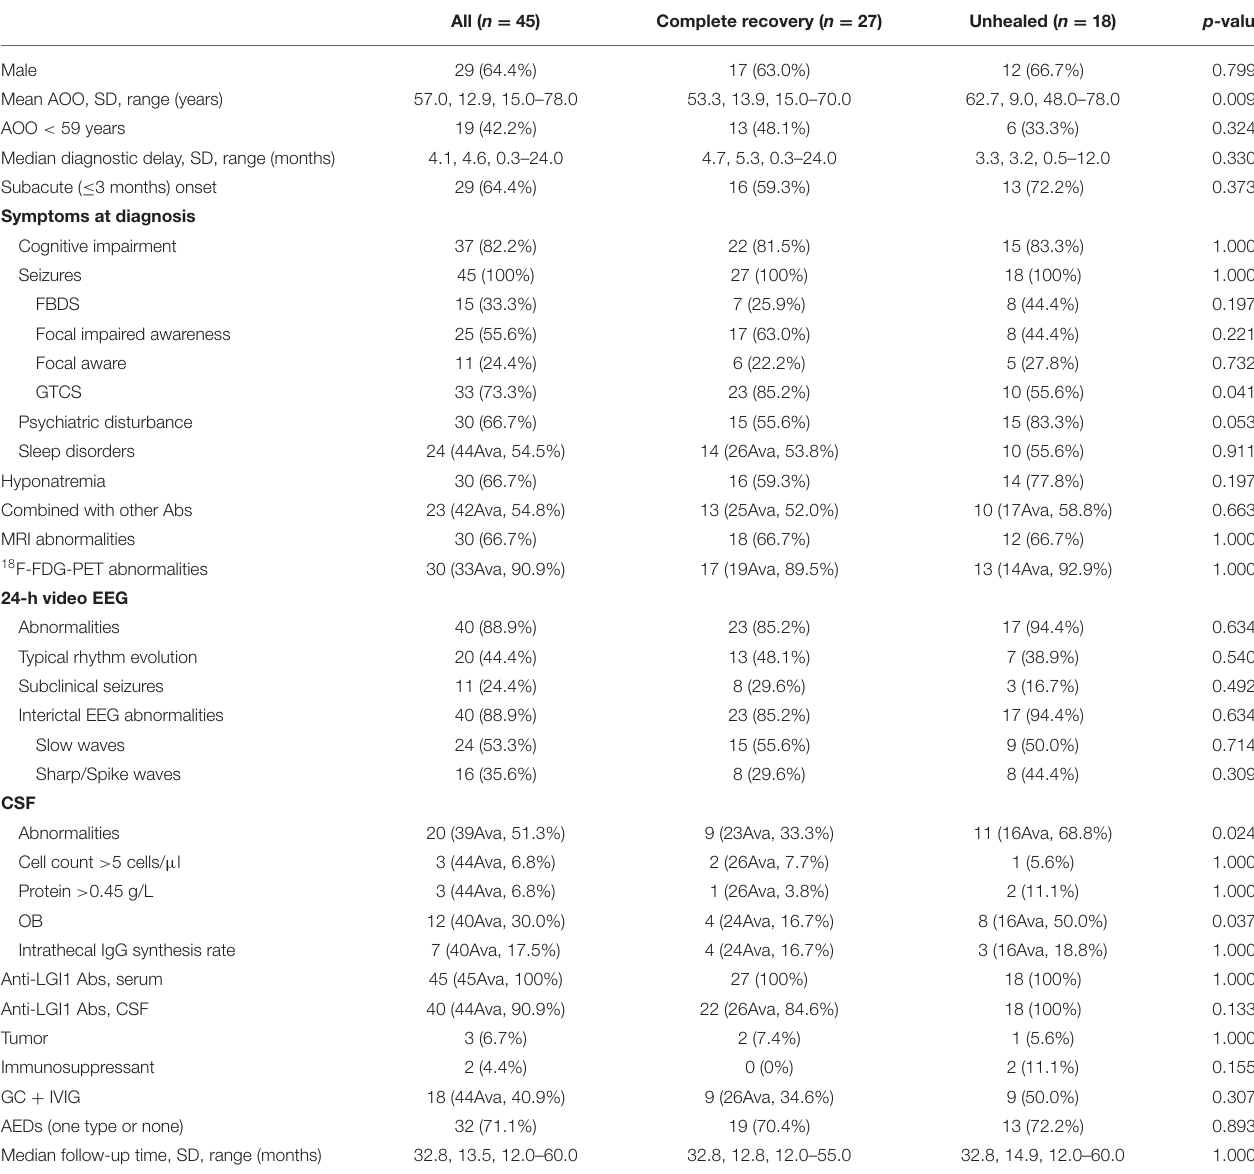
TABLE 1 | Clinical characteristics of patients with anti-LGI1